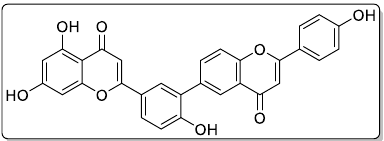
Figure 10. This is chemical formula of the compound 4 (Figure 5).